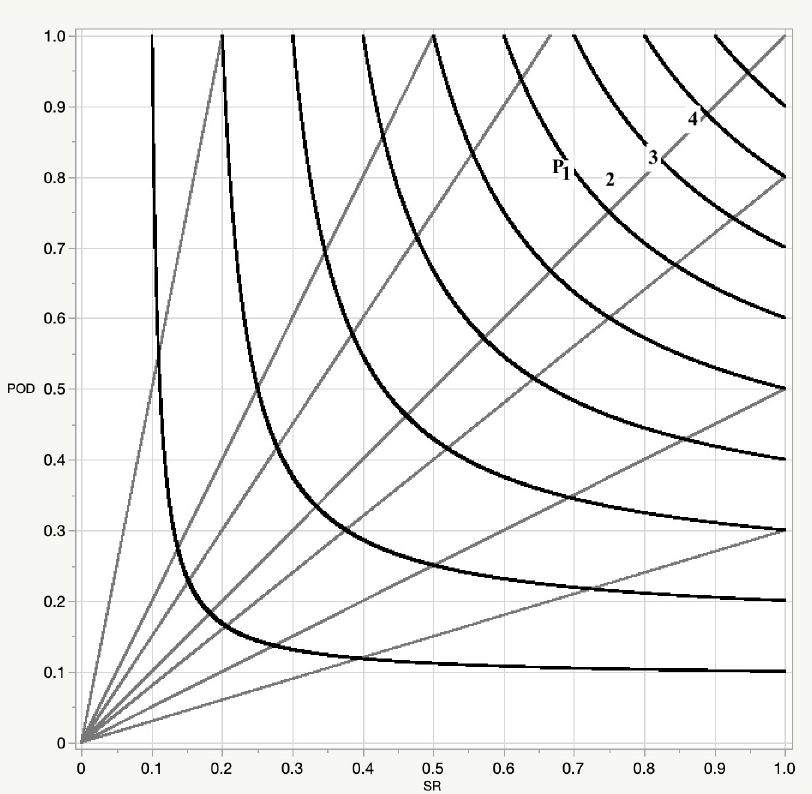
Fig 1. Performance diagram for the artificial neural network (ANN) prediction of win probability. The axes indicate success ratio (SR, equal to one minus the false alarm ratio) and probability of detection (POD). The straight lines emanating from the origin are bias values representing underforecasts below the 45˚ angle and overforecasts above. The curved lines are the threat score (also known as the critical success index, defined as hits divided by hits plus misses plus false alarms), starting at 0.1 on the lower left and increasing to 0.9 on the upper right. The points shown are performance of the point spread (P), and that of the neural network at the start of the first (1), second (2), third (3) and fourth quarters